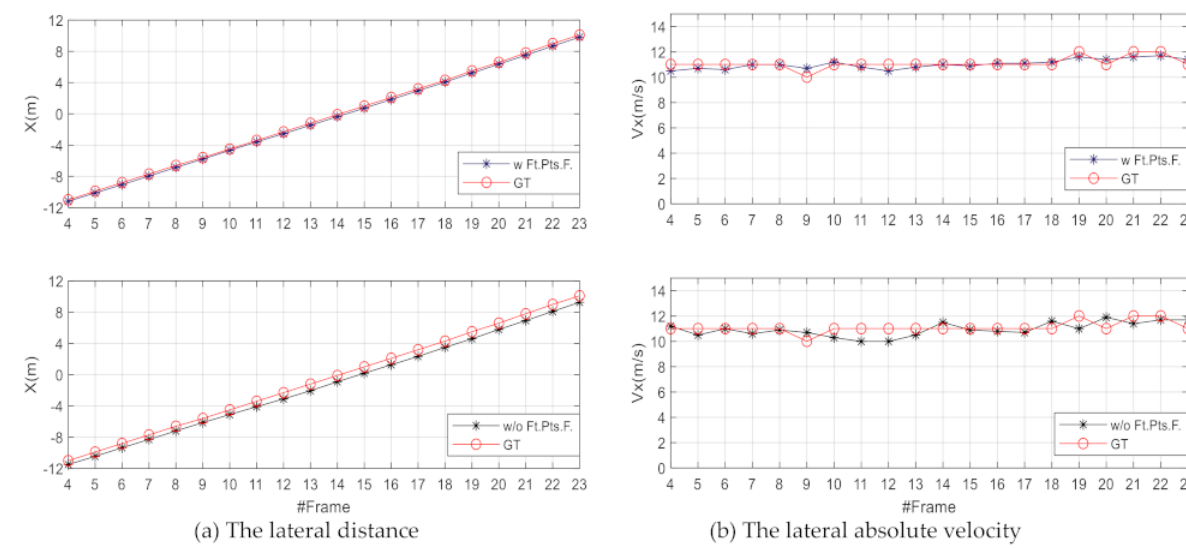
Figure 8. Variations of lateral distance and velocity of Obj. 4 over frame 4–23 in City scene. ( a ) The lateral distance; ( b ) The lateral absolute